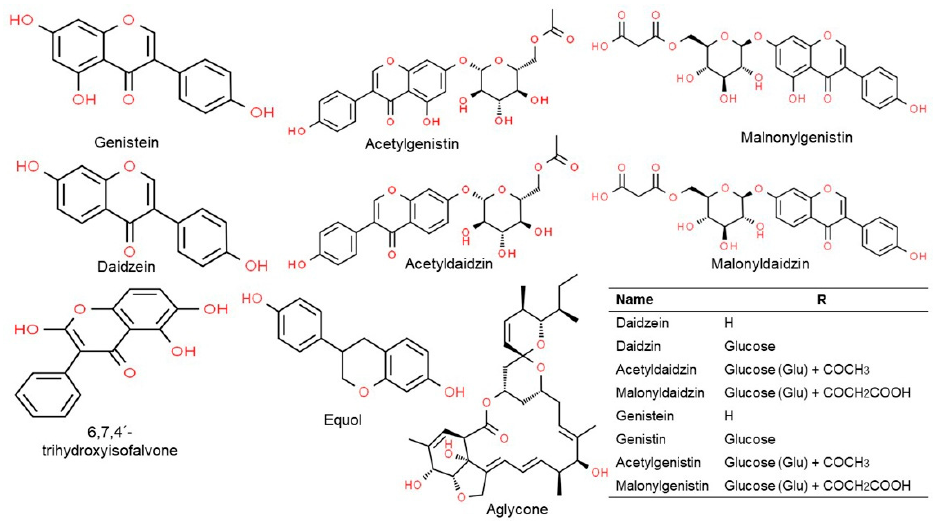
Figure 4. Chemical structure of the major classes of isoflavones. Structures were drawn using Chem Spider tool.